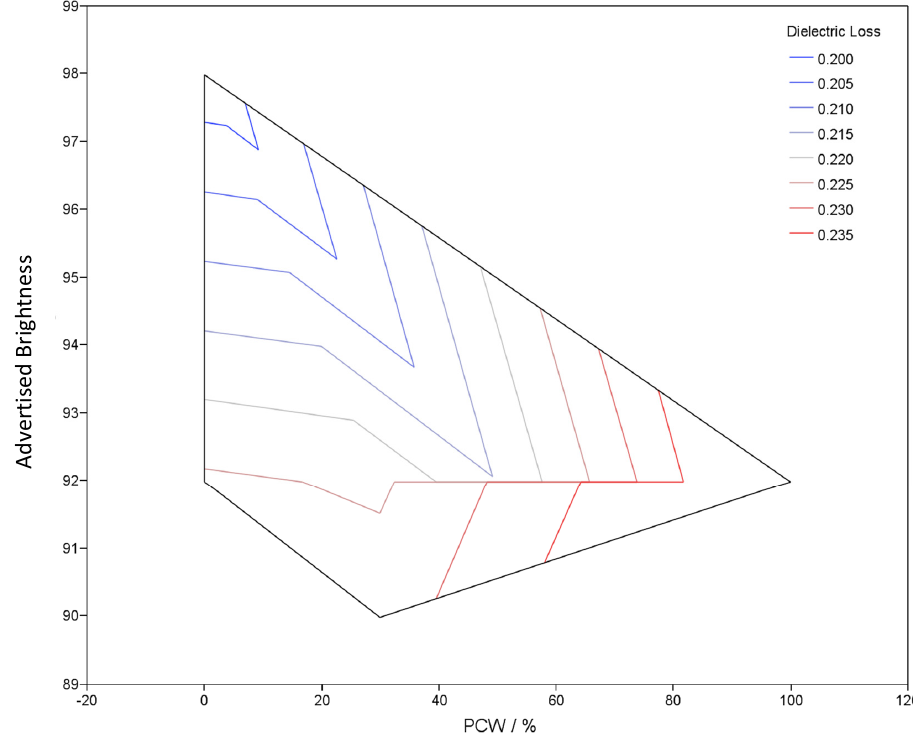
Figure 3. Contour plot showing the relationship between advertised brightness, percent PCW recycled fiber, and the dielectric loss for all the papers (virgin and recycled) as received studied in this work.